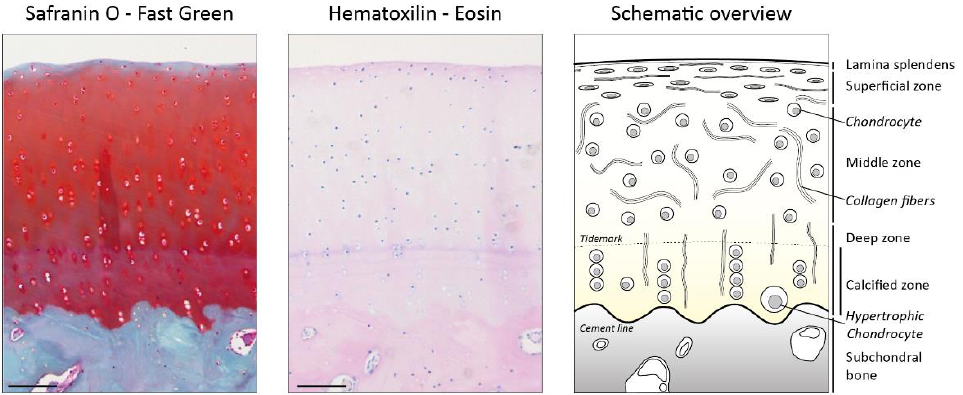
Figure 1. Appearance and structure of adult (bovine) articular cartilage. Note that the orientation of collagen fibrils differs per zone, from parallel in the superficial zone to perpendicular in the deep zone. Scale bar = 100 µm.